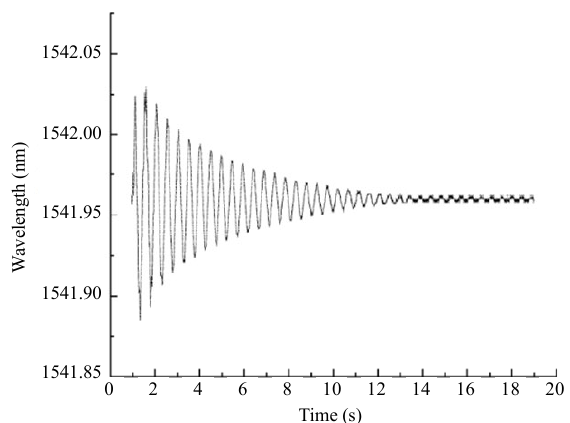
Fig. 3 Vibration responses at certain frequency.